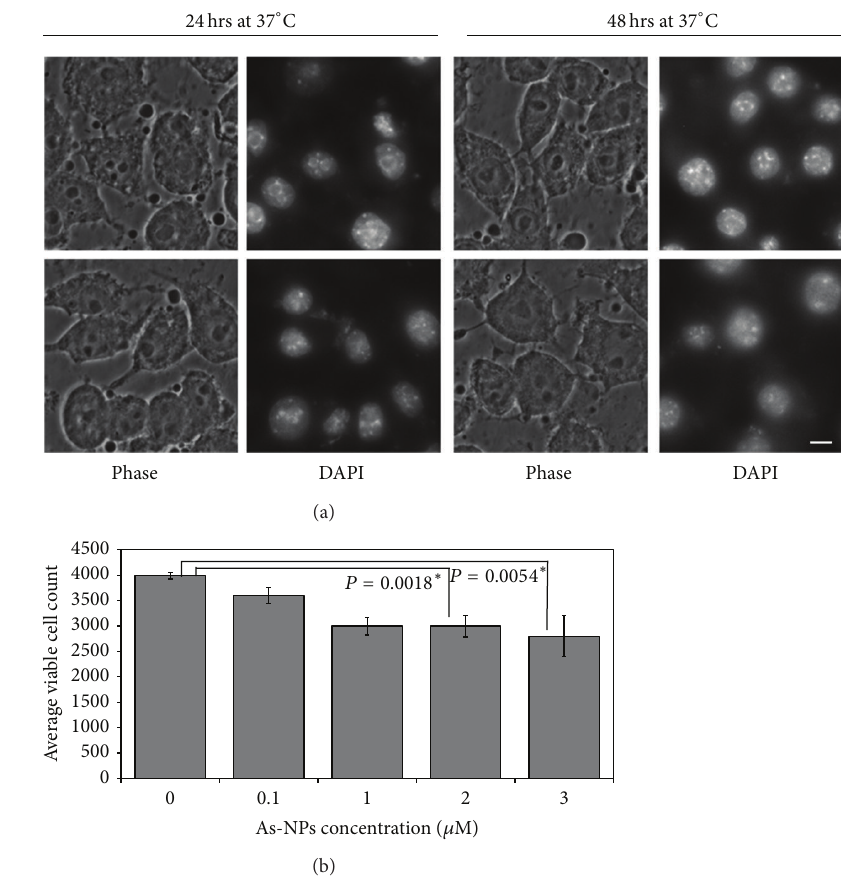
Figure 5: Effect of As-NPs on macrophages. (a) RAW cells were incubated without and with As-NPs (2 𝜇 M) for 24 and 48 hours at 37 ∘ C as indicated, following which, cells were stained with DAPI. Phase and DAPI images for each set are shown. These images are representative of several images obtained from multiple independent experiments. (b) The number of the viable cells in control (0) and sets treated with indicated concentrations of As-NPs was plotted. The number of the viable cells was calculated as mentioned in Section 2. In a separate experiment, a standard curve was generated to determine the equivalence of the cell numbers and the O.D. values. The number of viable cells in the untreated control set ( ∼ 4000) is less than that which was seeded initially (5000). Each column with error bar represents average ± SD, 𝑛 = 3 . ∗ denotes 𝑃 values ( < 0.05) of statistical